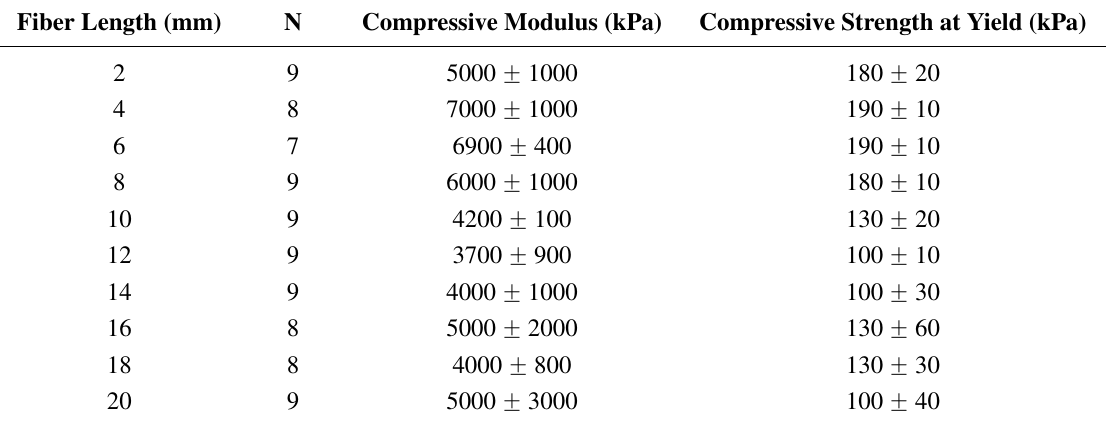
Table 5. Compressive moduli and yield strengths vs. fiber length for the silk compression series.